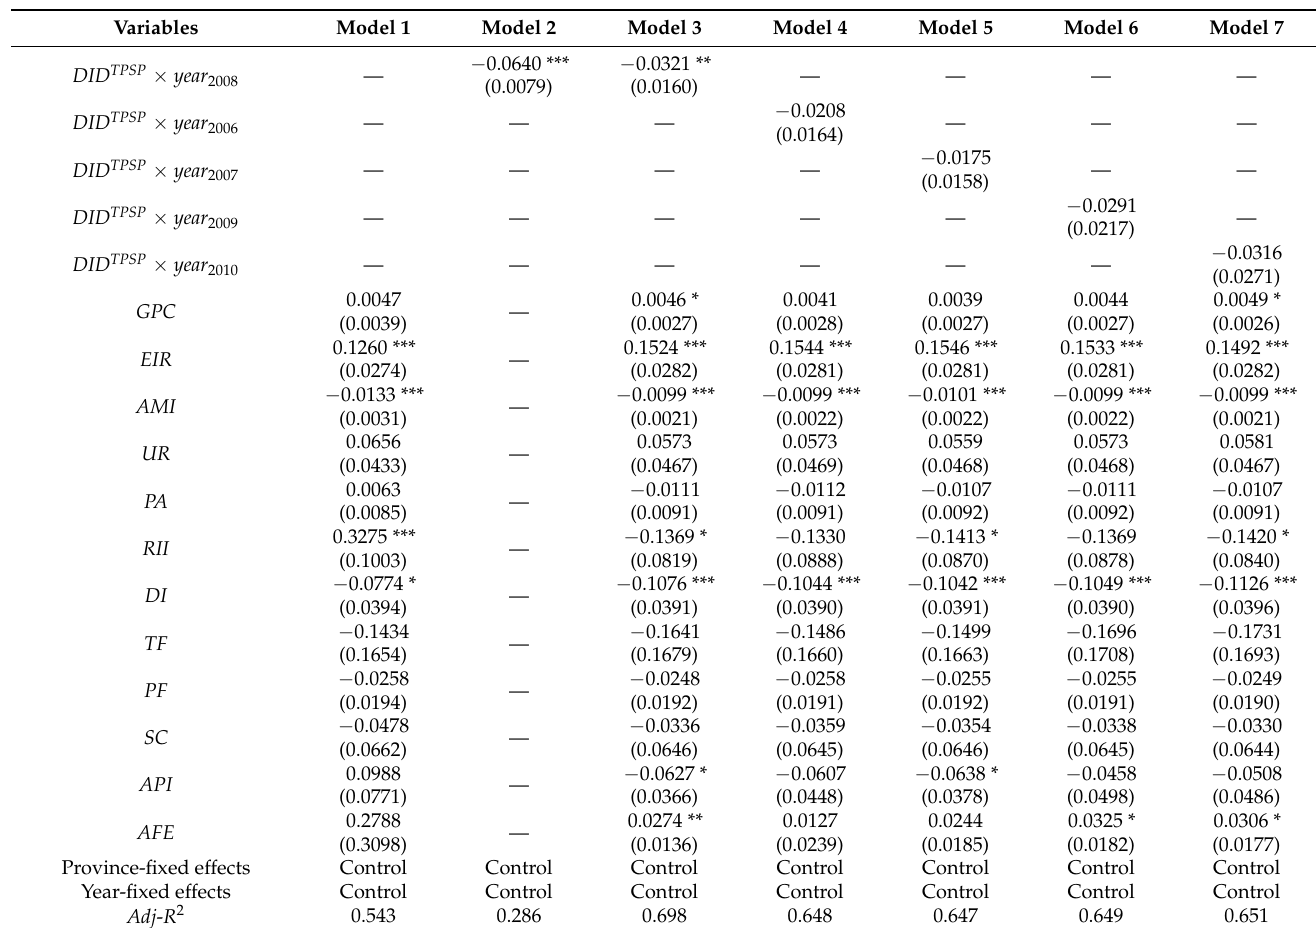
Table 4. DID analysis results of the TPSP.